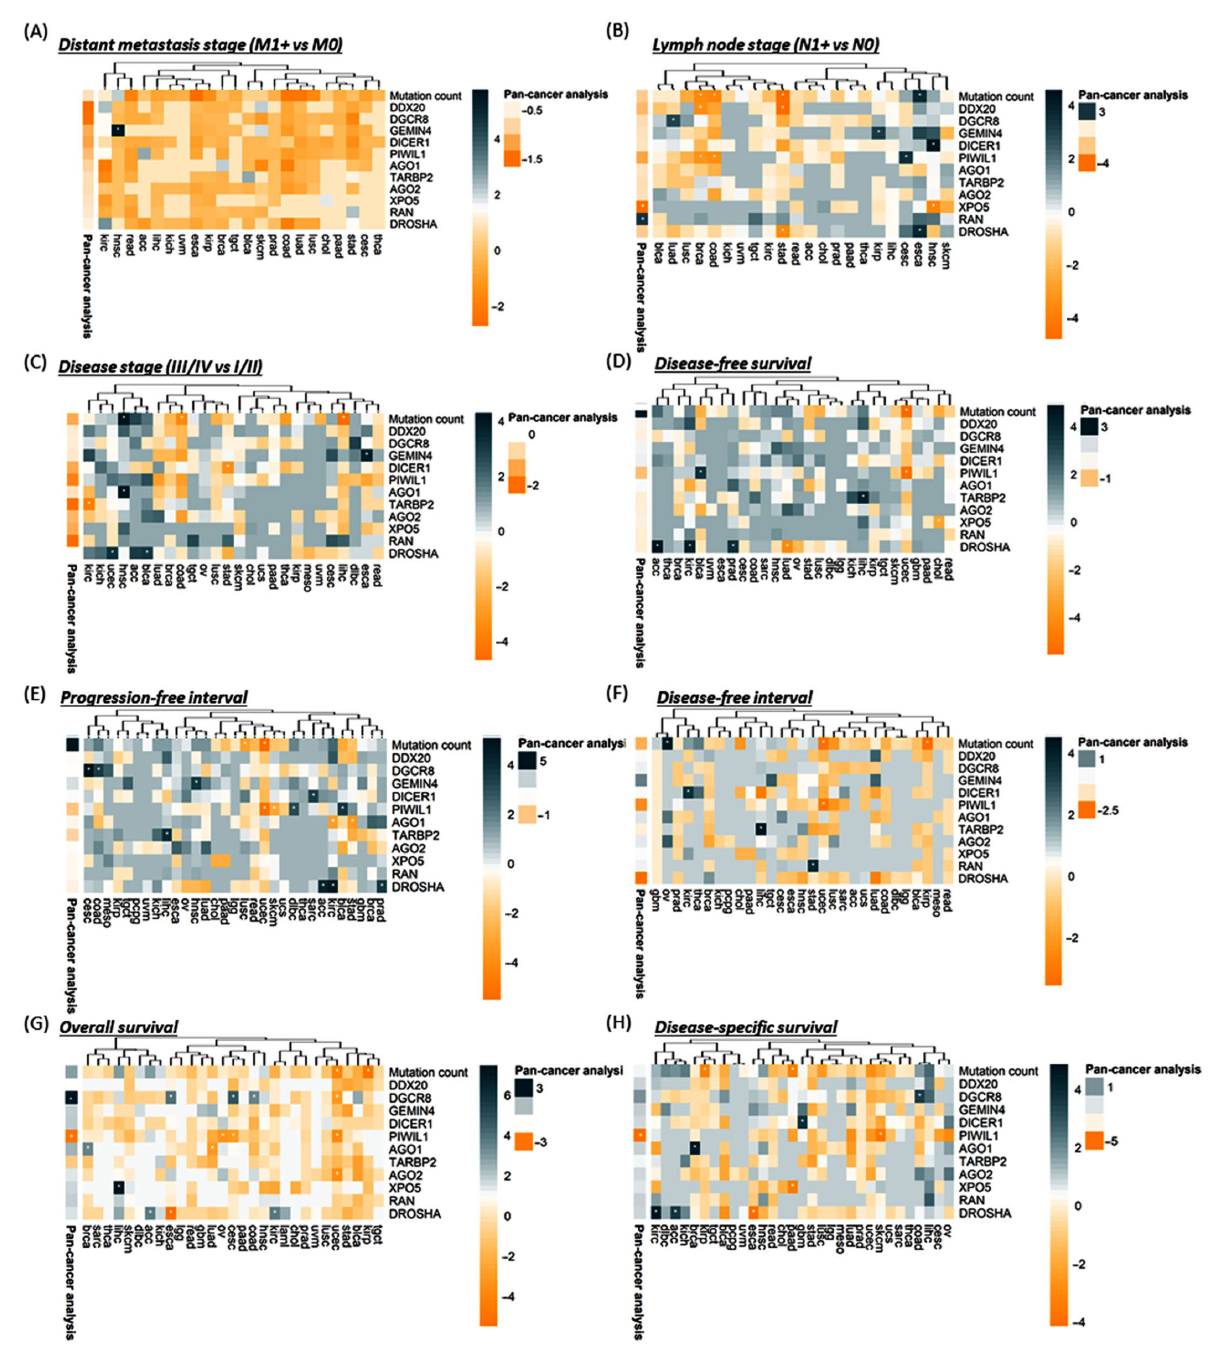
Figure 9. miRNA machinery gene mutations are potential prognosis markers in cancers. Heatmap representing the hierarchical clustering of the TCGA cancer types with the likelihood ratio p-values [Log( p -value)] obtained after logistic (for clinical parameters) and Cox (for outcome parameters) regression analyses between gene mutants/mutation count and clinical or survival parameters. The sign of Log( p -value) follows the sign of the regression beta-coefficient exponential. Annotation represents similar logistic regression in the pan-cancer study. * representing significant ( p < 0.05) logistic/Cox regressions.